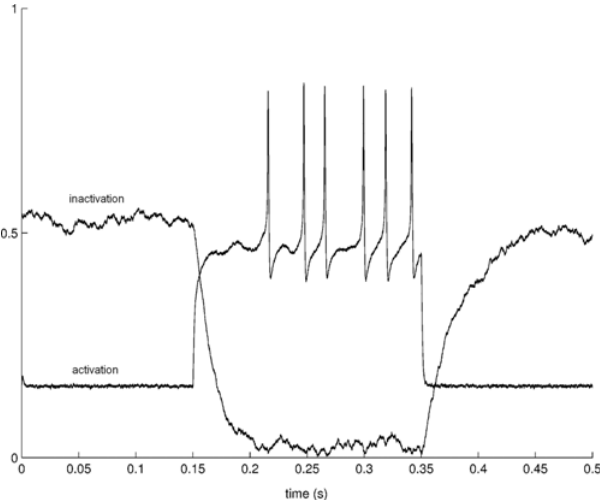
Figure 3. Frequency-current ( f-I ) curve of the stochastic granule cell model presented as a box and whisker plot. Depolarizing current pulses from 0 pA to 45 pA are used. For each value of depolarizing current we simulated 50 realizations, each 50 seconds long. Median, upper and lower quartiles, and the maximal and minimal firing frequencies are given for each depolarizing current pulse; outliers are marked with + symbol. Spontaneous activity is observed at low firing frequencies with depolarizing currents below 11 pA which is the firing threshold of the model. The f-I curve of the stochastic model is linear up to a frequency of 125 Hz, after which it shows saturation. For every realization s =0.5.